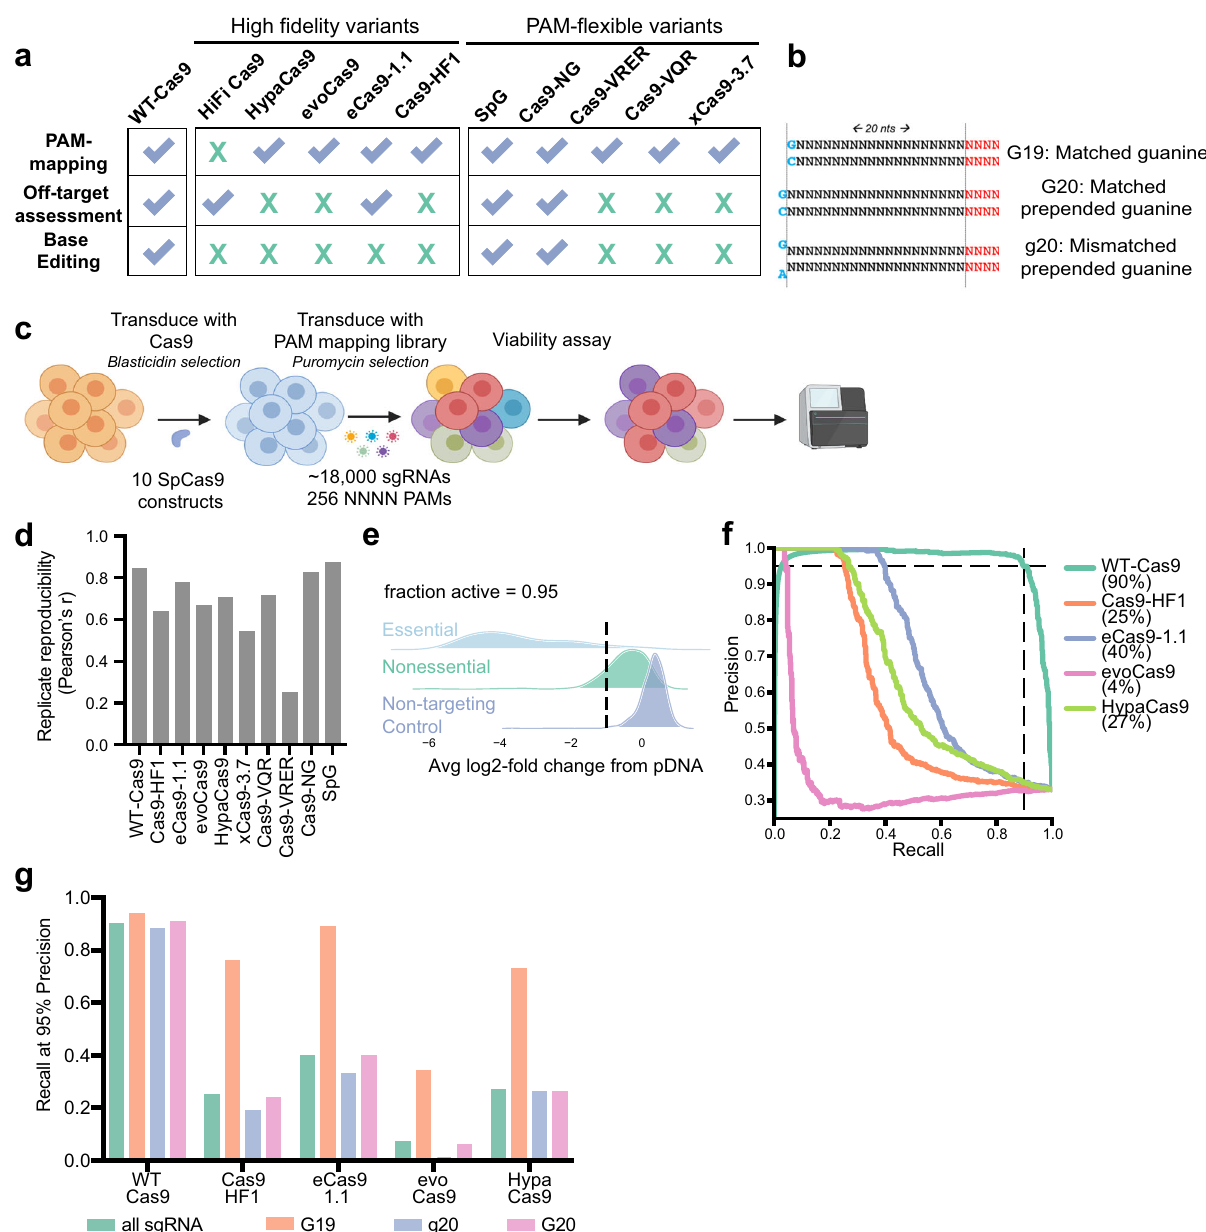
Fig. 1 Establishment of a benchmarking assay for Cas9 activity. a Summary of assays discussed in this manuscript and the Cas9 enzymes studied in each assay. HiFi-Cas9 was added at the off-target characterization stage, as our initial clone contained a mutation. b Schematic of the three 5 ′ -types screened. Location of the PAM sequence is indicated in red. c Schematic of PAM-mapping screens. d Replicate correlation (Pearson ’ s r), calculated from n = 2 experimental replicates for each variant screened. e Example fraction active calculation for WT-Cas9 at NGGN PAMs. f Precision-recall curves for WT- Cas9 and high- fi delity variants pro fi led with the PAM-mapping library. Guides of all 5 ′ -types are included in this calculation. Dashed lines designate the recall at 95% precision for WT-Cas9. g Recall values at 95% precision for WT-Cas9 and high- fi delity variants pro fi led with the PAM-mapping library (NGGN PAMs only), discretized by 5 ′ -type. Source data are provided as a Source Data fi